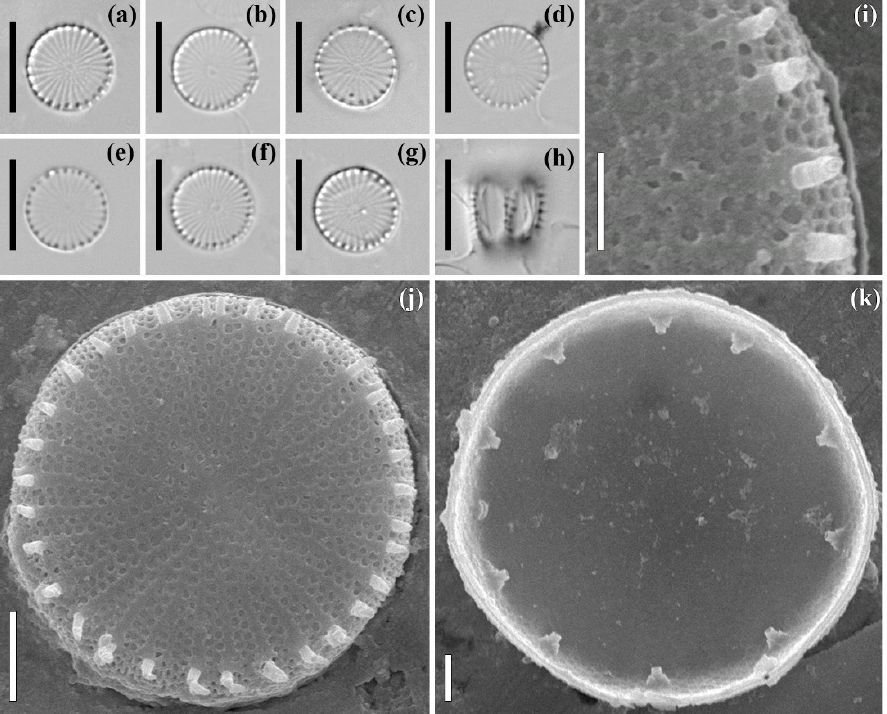
Figure 3. Stephanodiscus. hantzschii Grunow in Cleve & Grunow. Strain ARC05. Slide no. 08442.